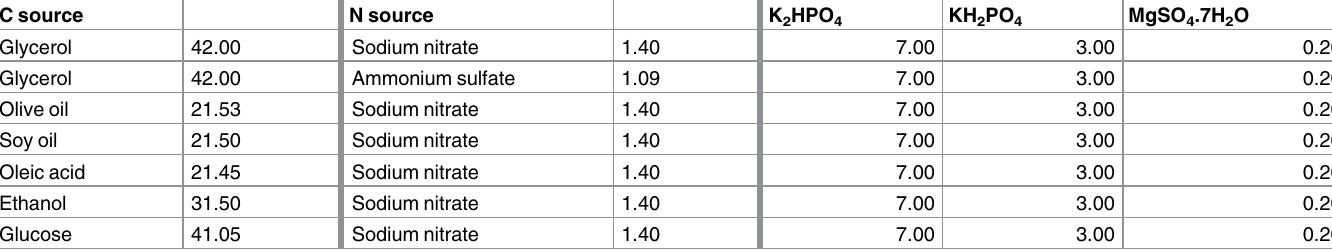
Table 2. Composition of the production media